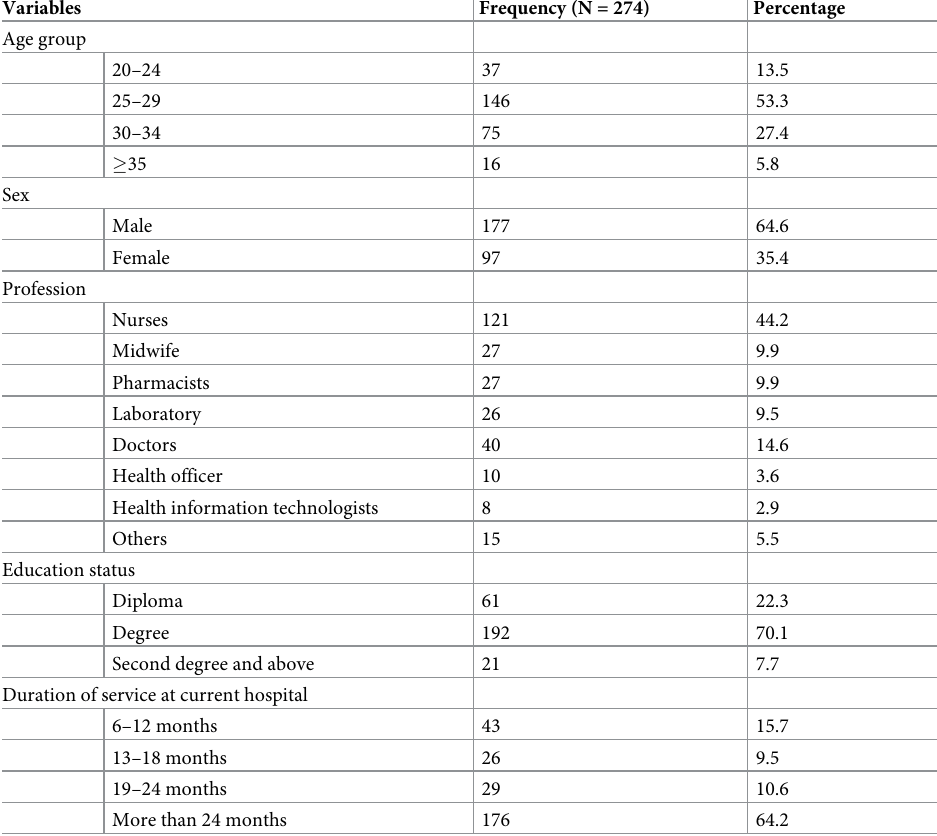
Table 1. Sociodemographic characteristics of health professionals working in general hospitals, Sidama region 2022.